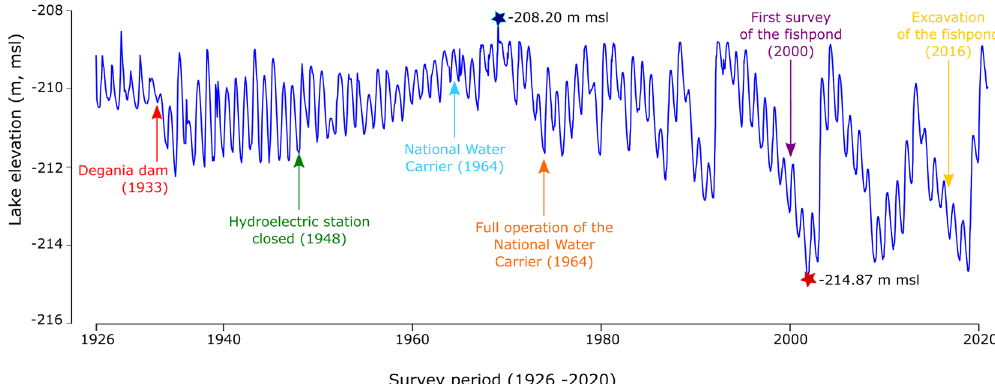
Figure 2. Mean monthly water levels of the Sea of Galilee between 1926 and 2020 (Data: Water Authority). Before the construction of the Degania dam (1933), the level of the sea fluctuated around -210 m msl. The magnitude of the fluctuations increased when the hydroelectric station was in operation. The use of the Sea of Galilee as freshwater reservoir further accentuated the fluctuations. The arrows represent the main interventions that have affected the natural variability of the lake level and the date of the excavation of the structure. The minimum water level has been recorded in November 2001 (red star; -214.87 m msl) and the maximum water level in February 1969 (blue star; -208.39 m msl).